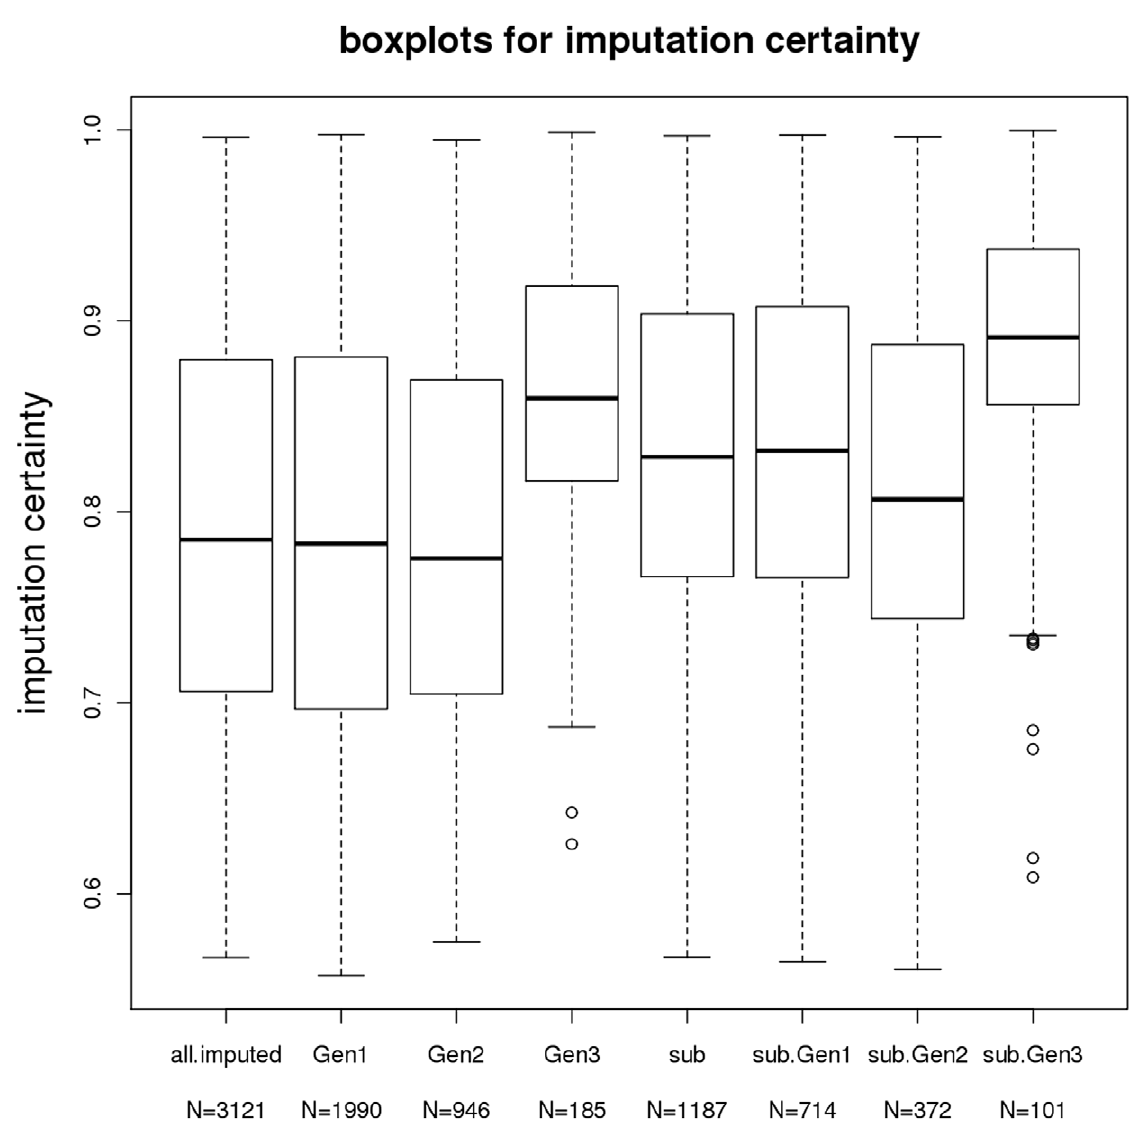
Figure 1. Box plots of imputation certainty in FHS imputed samples.